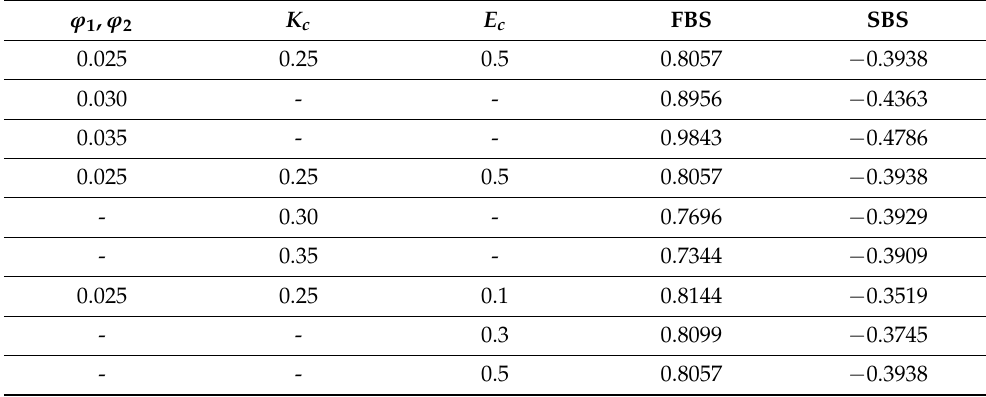
Table 5. Quantitative values of CSC for the several distinct parameters when ε c = − 1.5, γ c = − 1.0,